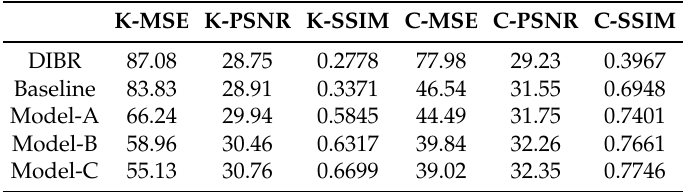
Table 3. Quantitative comparisons on KITTI and Cityscapes